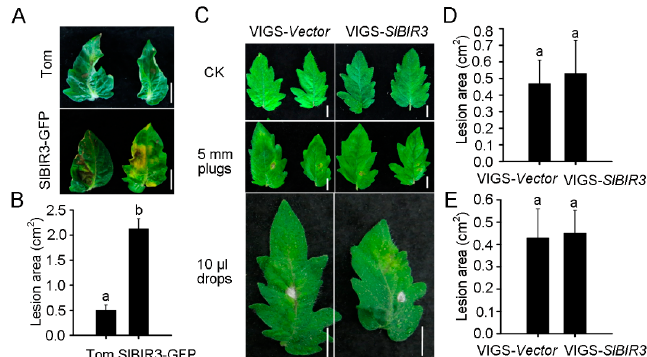
Figure 5. SlBIR3 suppresses resistance to B. cinerea in tomato. ( A ) Disease phenotypes of wild type (Micro-Tom) and SlBIR3-overexpression seedlings (Micro-Tom background) after drop inoculation with 10 µ L of B. cinerea spores suspension (5 × 10 5 spores/mL). The photographs show leaves 7 days after the inoculation. The upper panel shows wild type leaves (labeled Tom) and the lower panel shows leaves of SlBIR3-overexpression plants. Scale bars, 10 mm; ( B ) The lesion areas in the leaves shown in ( A ); ( C ) Disease phenotypes of SlBIR3 silenced leaves (cv. moneymaker). The left panel shows the empty vector control leaves (VIGS- vector ) and the right panel shows SlBIR3 silenced leaves (VIGS- SlBIR3 ). The upper panel shows the untreated leaves, the middle panel shows the leaves incubated with 5 mm diameter mycelium plugs of B. cinerea and the lower panel shows the leaves incubated with 10 µ L drops of a B. cinerea spores suspension (5 × 10 5 spores/mL). Scale bars, 10 mm; ( D ) The lesion areas of leaves incubated with 5 mm diameter mycelium plugs of B. cinerea shown in ( C ); ( E ) The lesion areas of leaves incubated with 10 µ L drops of B. cinerea spores suspension shown in ( C ); The lesion areas of 5 leaves were measured and the values indicate mean values ± SD. Significant differences are indicated by different letters according to a Student’s t test ( p < 0.05). Experiments were performed three times with similar results.